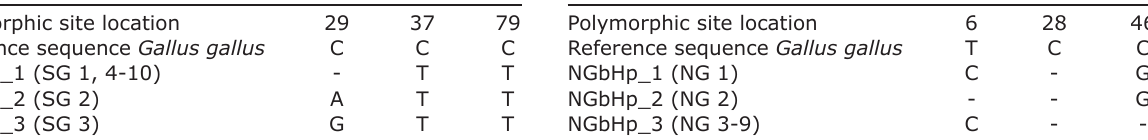
a Figure-2: Raw sequences (blue bars) and electropherogram (colored peaks) of COX I gene of representative samples of Aravali (a) and Ankleshwar (b) population. (a) NG05 (b) SG01. Table-3: Molecular definition of three COX I haplotypes from Ankleshwar chicken population.